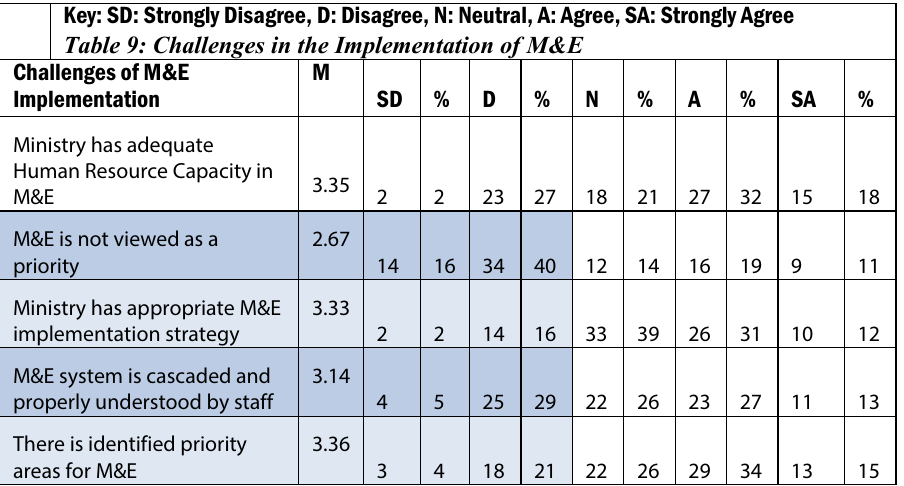
Table 9: Challenges in the Implementation of